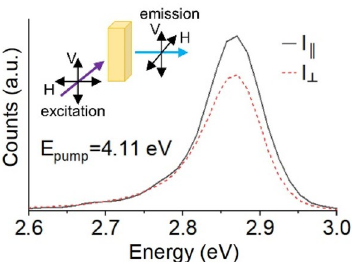
Fig. 2 Photoluminescence of 2 ML CsPbBr 3 NPLs for different pump energies and polarizations. Inset is a cartoon of the measurement conditions: measurements are performed on toluene solution ensembles, using polarized vertical or horizontal excitation and vertical or horizontal polarization of the emitted photoluminescence at 90° from the pump excitation